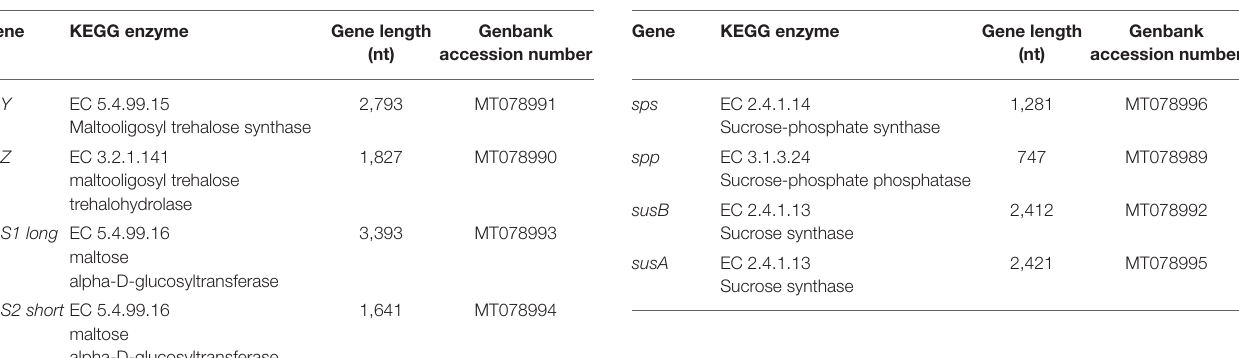
TABLE 3 | Genes encoding sucrose biosynthetic enzymes in Chroococcidiopsis sp. CCMEE